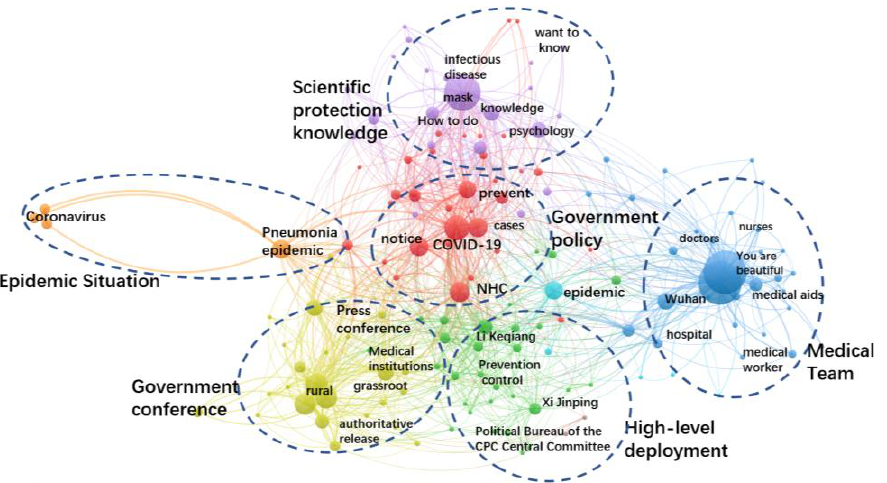
Figure 7. Keywords co-occurrence network of government information supply in the outbreak stage.